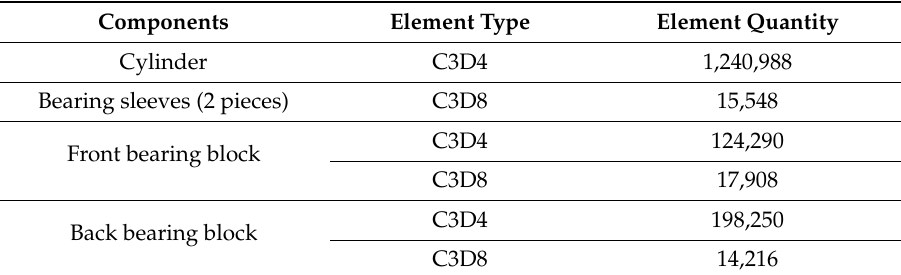
Table 4. Element type and quantity of the components in FE model.